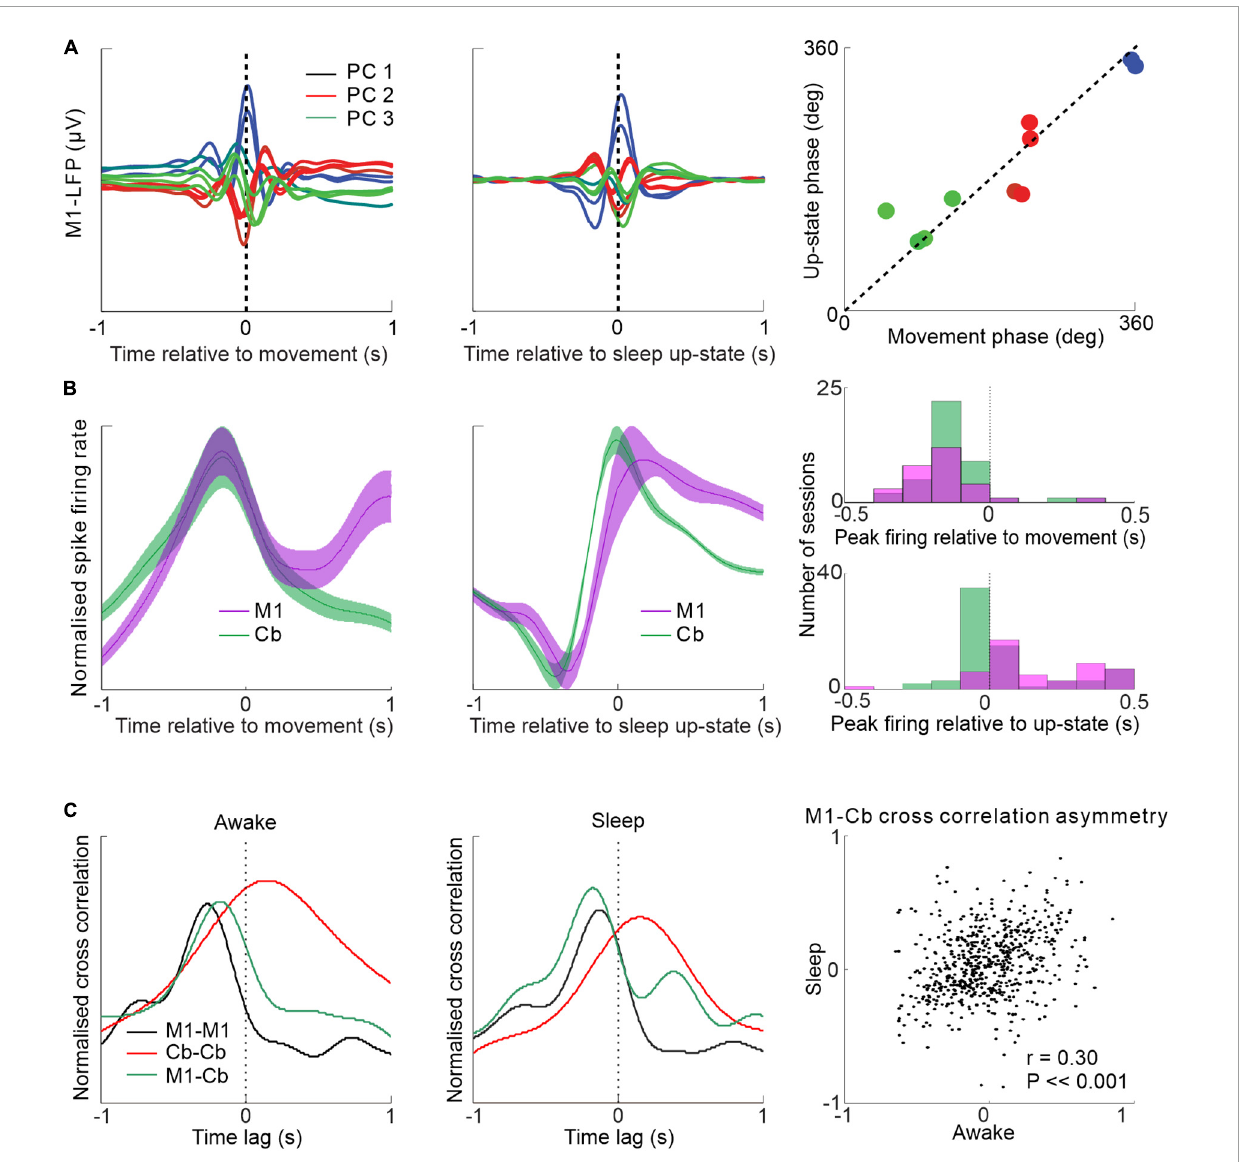
FIGURE4 Low frequency M1-cerebellar interactions during movement and sleep. (A) Similar patterns of M1 LFPs aligned by waking movement and sleep slow oscillation. (B) M1 and cerebellar spike firing rates aligned to wrist movement during visuomotor task (left) and aligned to sleep up-state (middle) showing relative synchrony during the former and a relative cerebellar lag during the latter (right). (C) Spike cross-correlograms between pairs of neurons within M1, within cerebellum and between M1 and cerebellum during waking and sleep are similar (left and middle). M1-cerebellar cross-correlation temporal patterns are correlated between waking and sleep (right). Figures adapted with permission from Hall et al. (2014) and Xu et al.